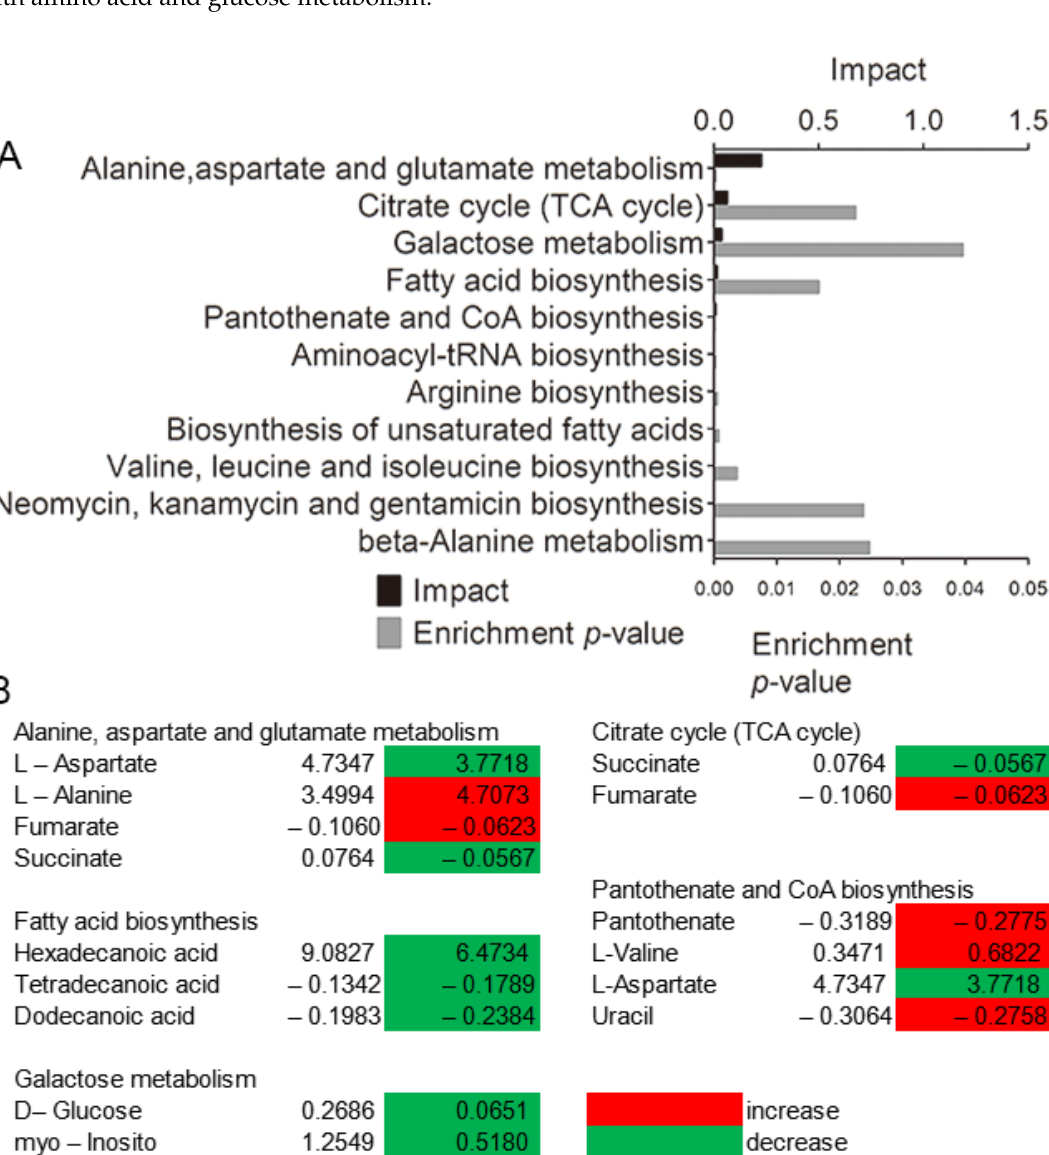
Figure 4. ( A ) Enriched pathways in the presence of the EO significantly enriched pathways were plotted. ( B ) Heat map of the average levels of differential metabolites in the five enriched pathways shared by the two groups. Red and green, respectively, indicate increase and decrease in the metabolites scaled to mean and standard deviation of row metabolite level (see the color scale).